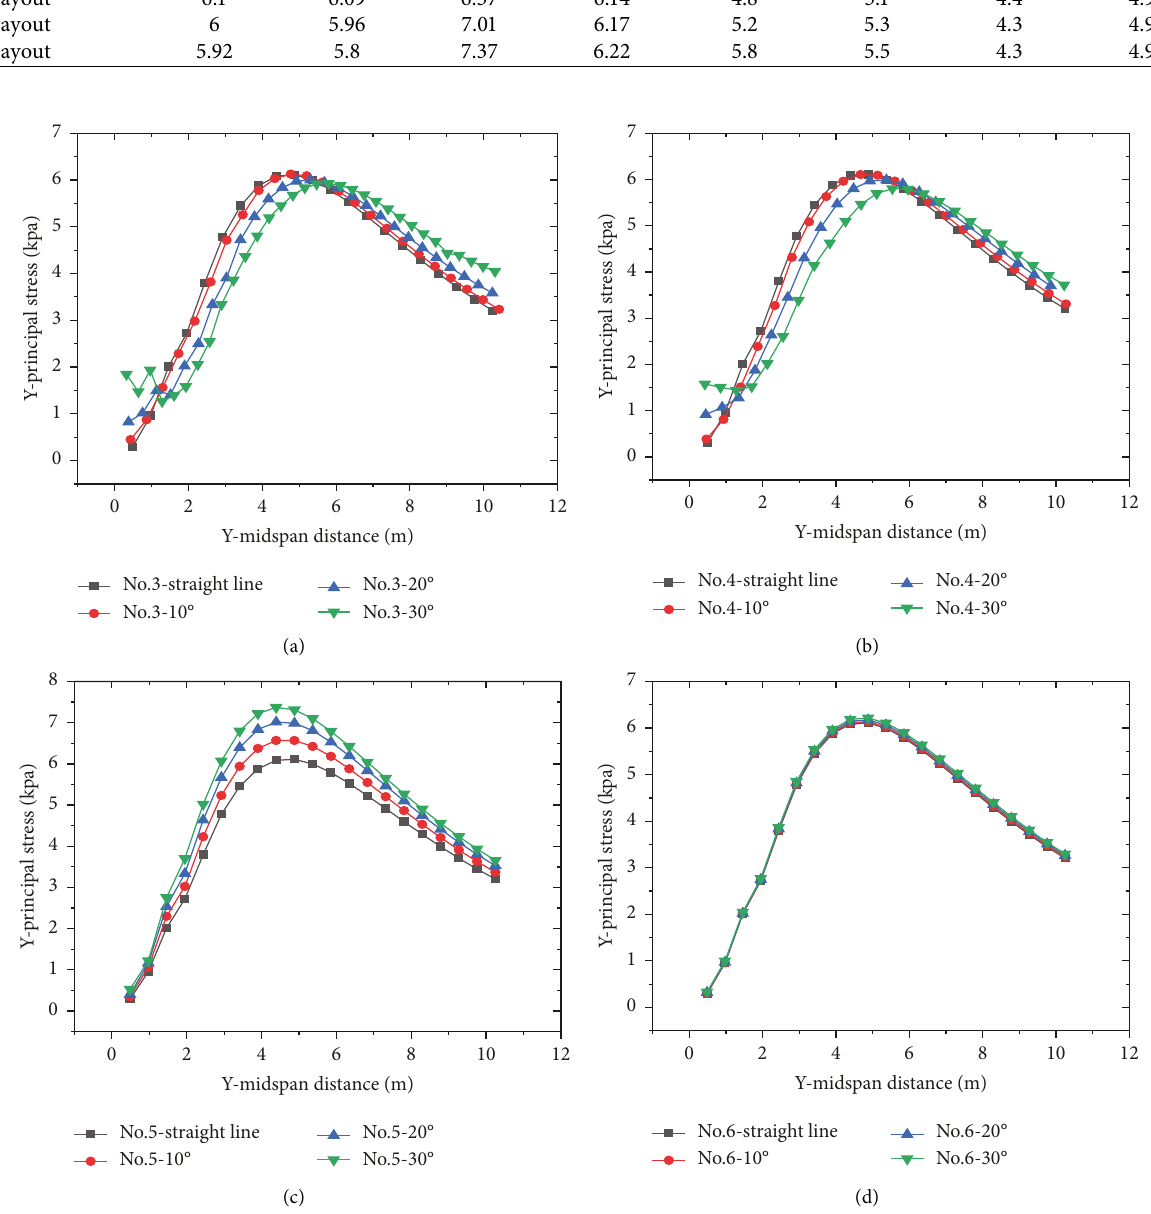
Figure 12: Variation curves of Y-directional principal stresses of soil arches at various pile layout